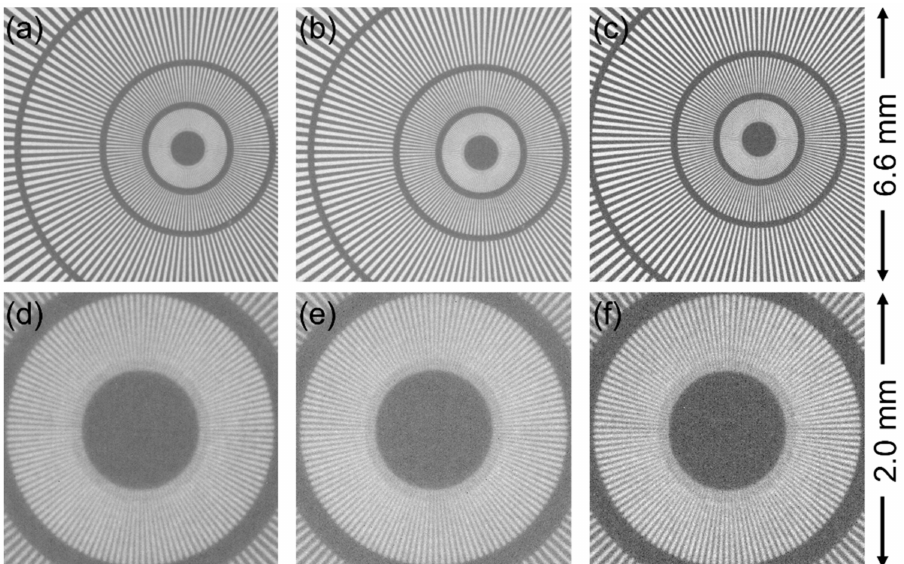
Figure 4. High-resolution neutron radiography taken at 2 × magnification under L / D = 300 conditions by three types of scintillators: ( a ) an image taken with P43 (10 µ m), ( b ) an image taken with GAGG (100 µ m), ( c ) an image taken with GAGG (10 µ m), ( d ) an enlarged view of ( a ), ( e ) an enlarged view of ( b ), and ( f ) an enlarged view of ( c